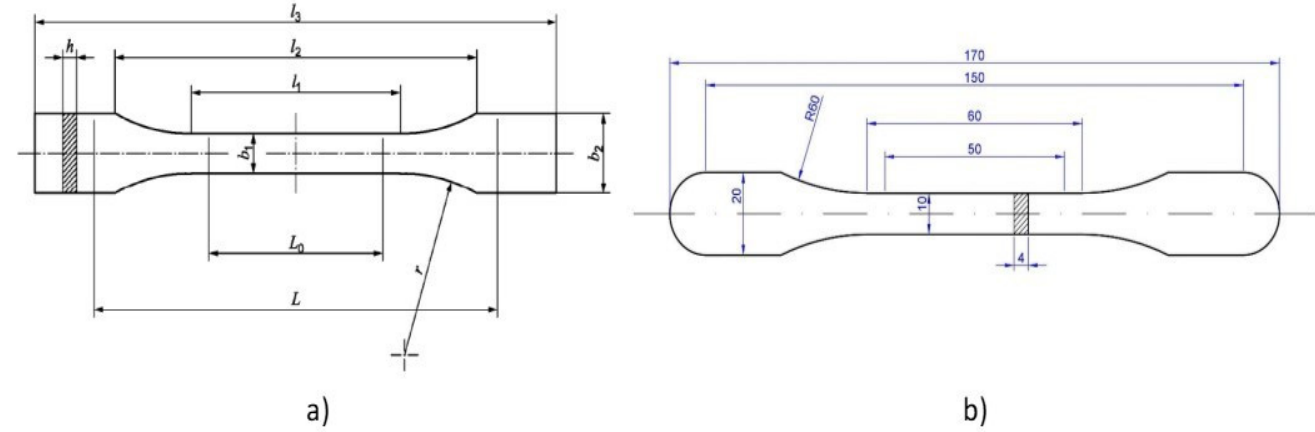
Figure 5. ( a ) Specimen geometry (ISO 527-2) and ( b ) modified specimen geometry. Table 4. Reference code.